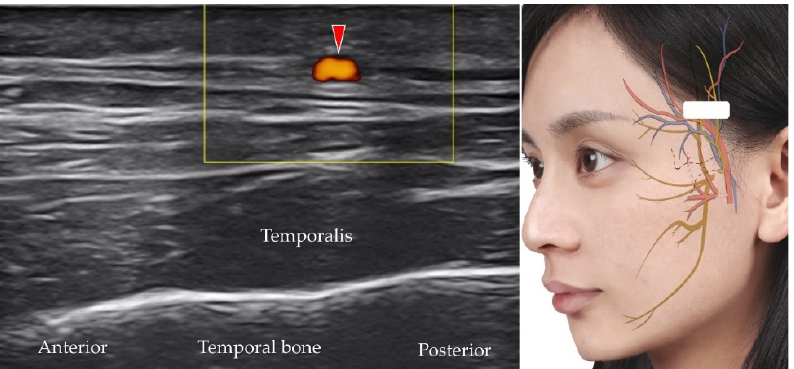
Figure 14. Power Doppler ultrasound imaging of the parietal branch of the superficial temporal artery (red arrowhead) . White square , footprint of the ultrasound transducer.